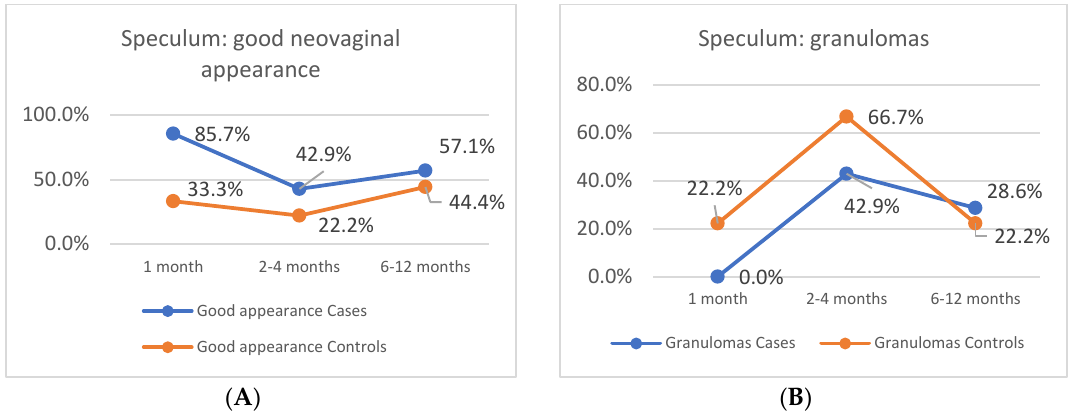
Figure 3. Speculoscopy. ( A ) Percentage of patients with a good neovaginal appearance. ( B ) Percentage of patients with neovaginal granulomas.